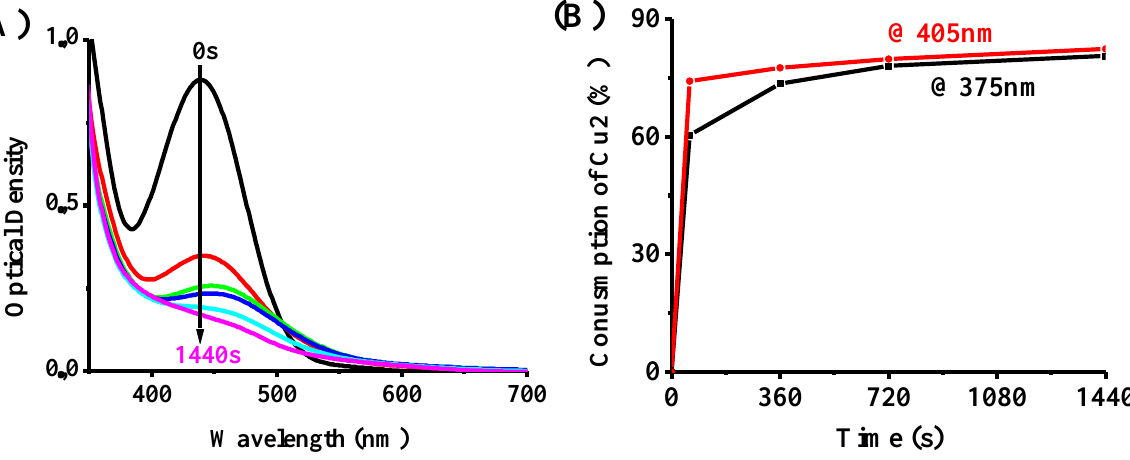
Figure 11. ( A ) Photolysis of Cu2 with Iod (10 −2 M) upon irradiation @375 nm. ( B ) Consumption of Cu2 with irradiation @375 nm and 405 nm.